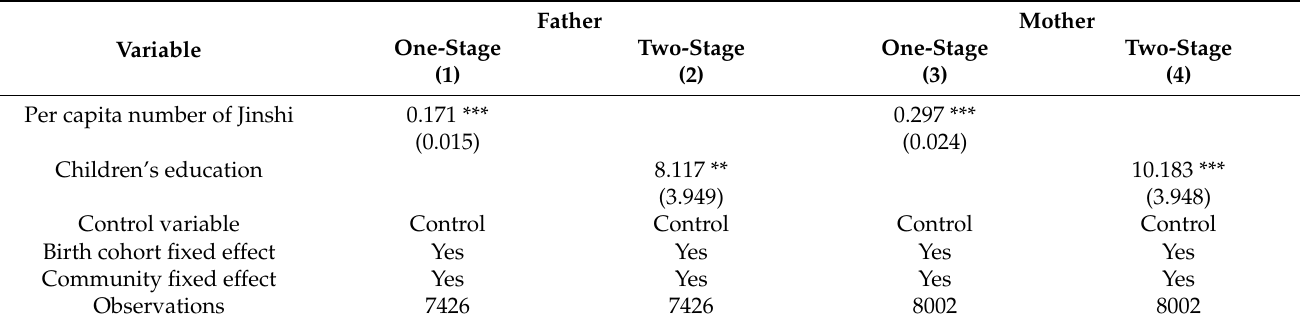
Table 4. Estimation results of the instrumental variable